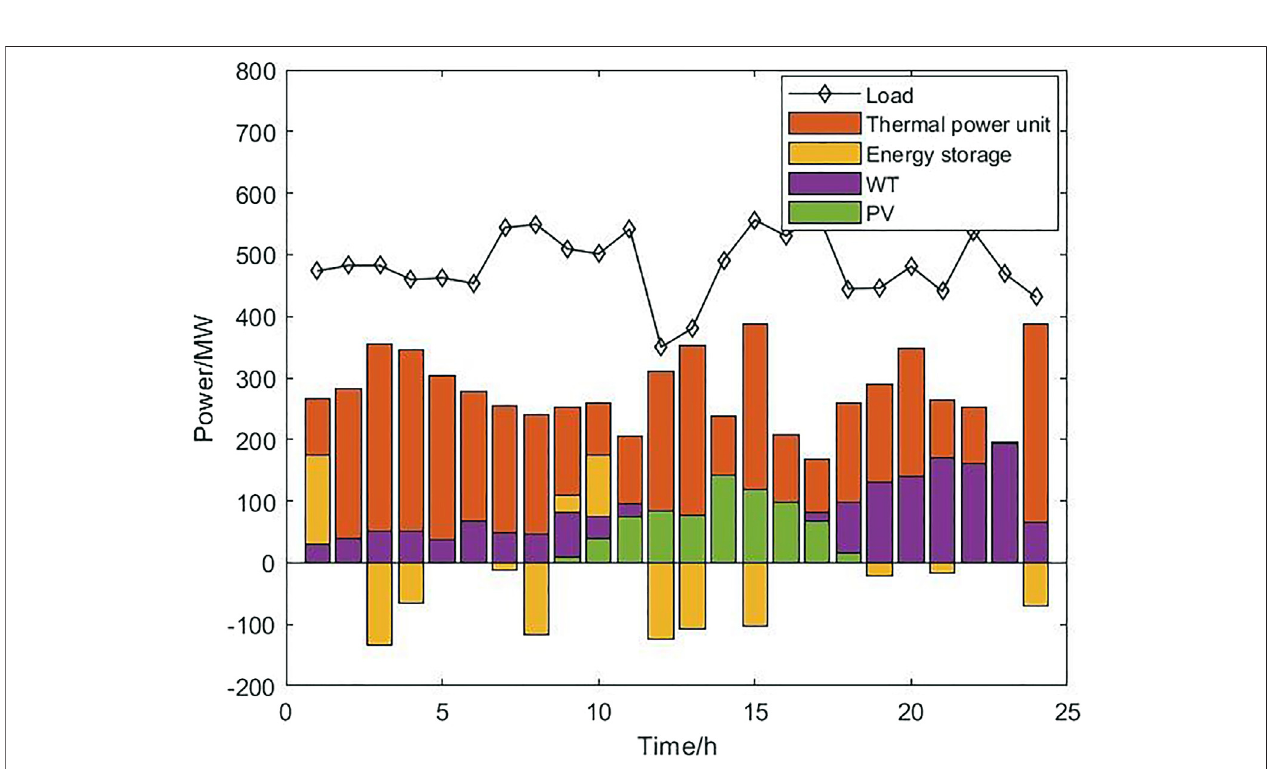
FIGURE 3 | Simulation results of the output of each unit.